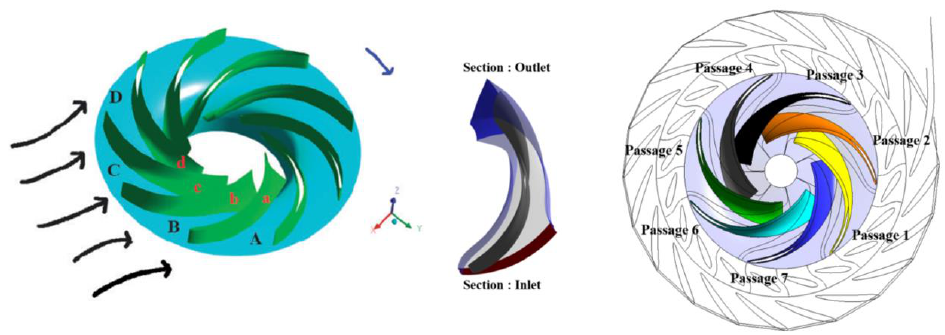
Figure 18. Schematic of the mechanism of the rotating stall (RS), and inlet and outlet section of a blade, and numbering of the passages.